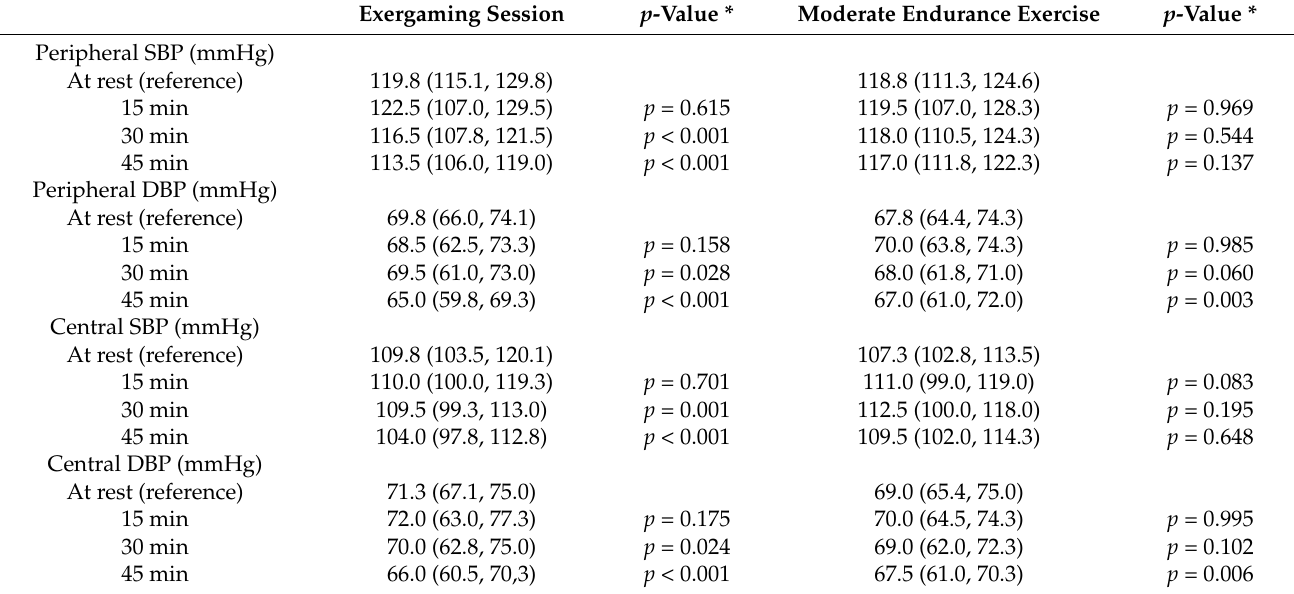
Table 2. Peripheral and central SBP and DBP at rest before and 15, 30, and 45 min after exercise. Exergaming